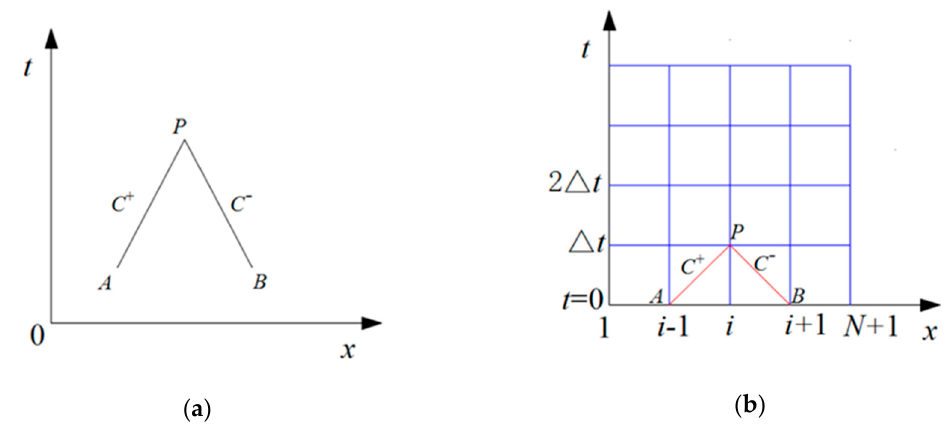
Figure 1. Characteristic line schematic diagram and grid: ( a ) Characteristic lines on x-t plane; ( b ) X-t feature line grid.